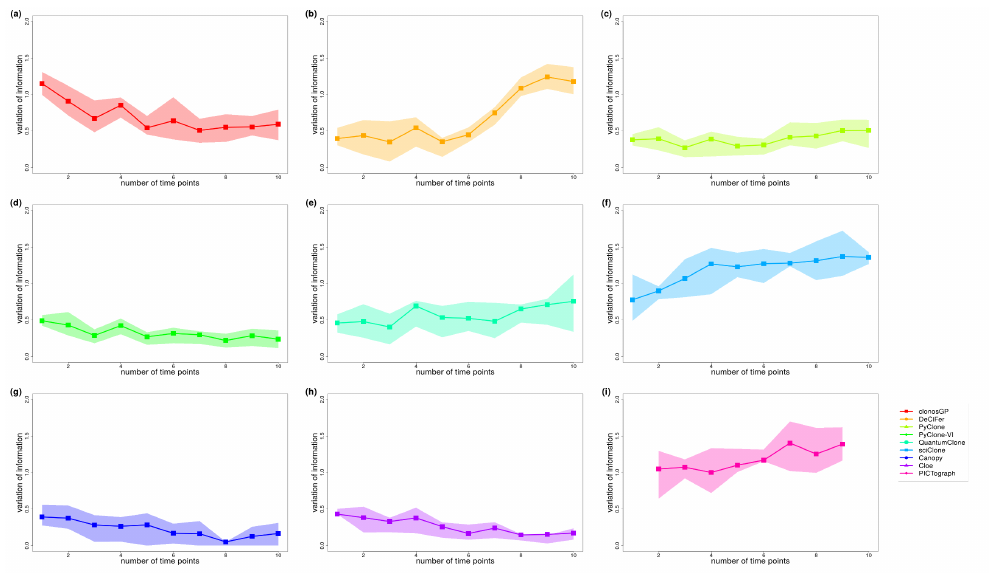
Figure A11. Number of clusters reported using ( a ) clonosGP, ( b ) DeCiFer, ( c ) PyClone, ( d ) PyClone- VI, ( e ) QuantumClone, ( f ) sciClone, ( g ) Canopy, ( h ) Cloe, and ( i ) PICTograph, in the absence of CNVs for varying numbers of time points. Light background colors indicate the Q 1 and Q 3 quartiles.